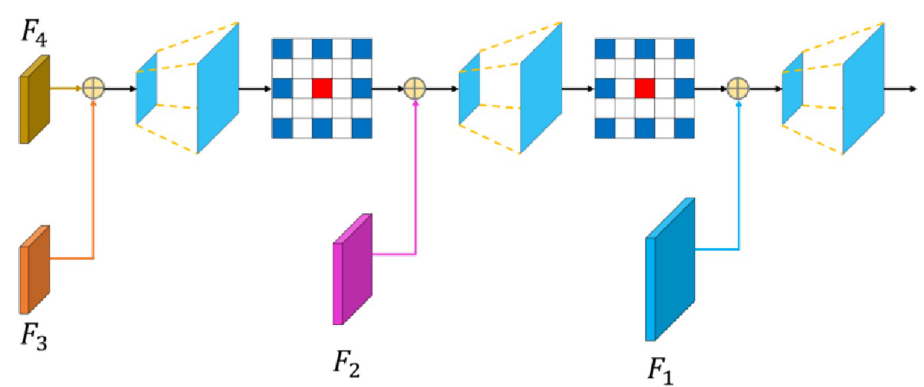
Fig 8. The structure of the context information aggregation decoder.